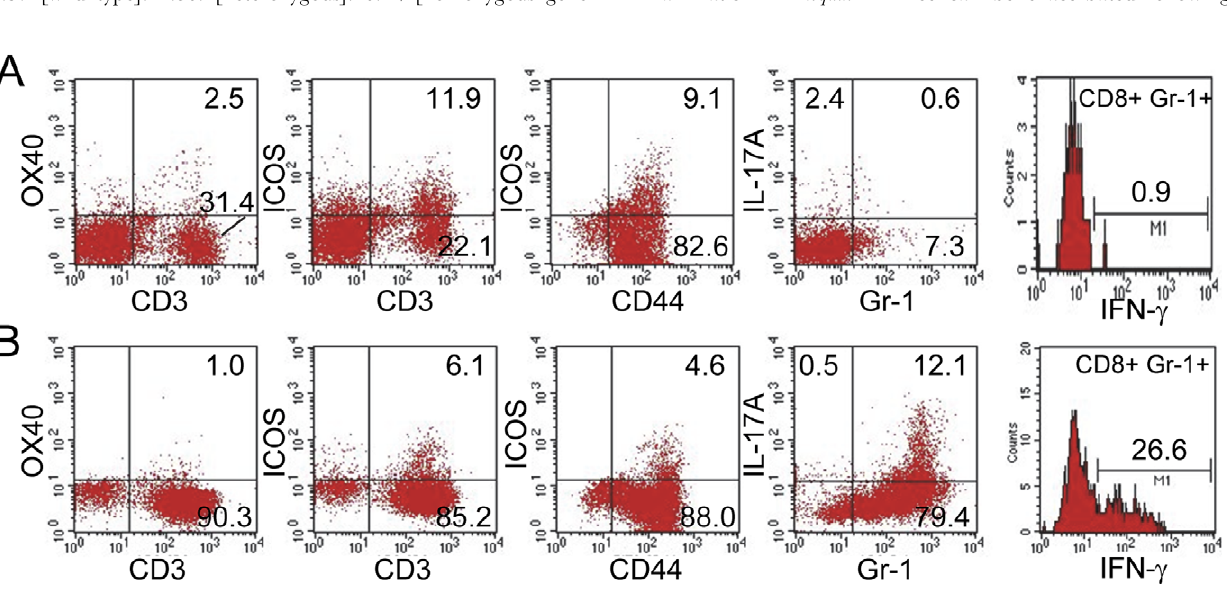
Figure 7. Unique phenotypic profile of siLPLs in Roquin san/san mice. siLPLs in Roquin san/san mice differed fundamentally from those in normal mice in that Roquin san/san mice had an unusually high proportion of GR-1 + T cells as determined by CD3 expression. The majority of those cells were CD44 + and they included a subset of IL-17A secreting cells. A subset of CD8 + Gr-1 + cells express IFN- c (panel B compared to panel A ). Representative data from 2–3 normal and Roquin san/san mice.